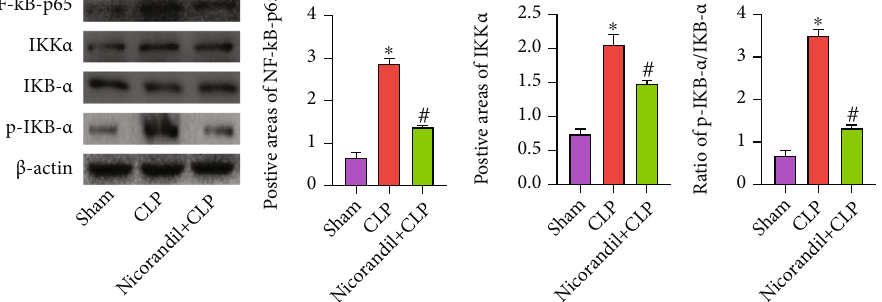
Figure 4: E ff ect of nicorandil on the expression of NF- κ B pathway-related proteins in rat myocardium. Western blot detected the expression of NF- κ B, Ikk α , IkB- α , and p-IkB- α in myocardial tissue and analyzed the gray value of the protein bands. “ ∗ ” P < 0 : 05 vs. sham group; “ # ” P < 0 : 05 vs. CLP